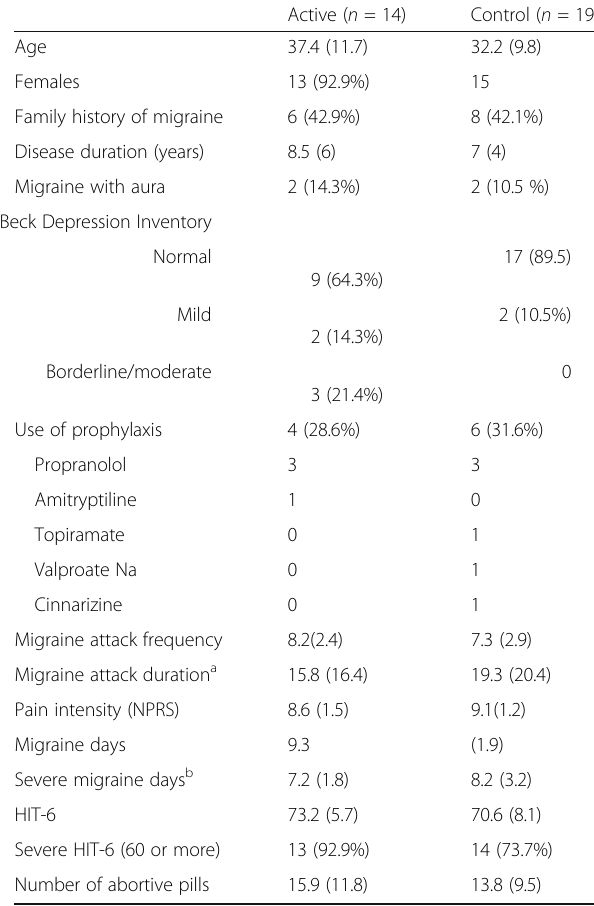
Table 1 Baseline characteristics of patients in the two studied groups